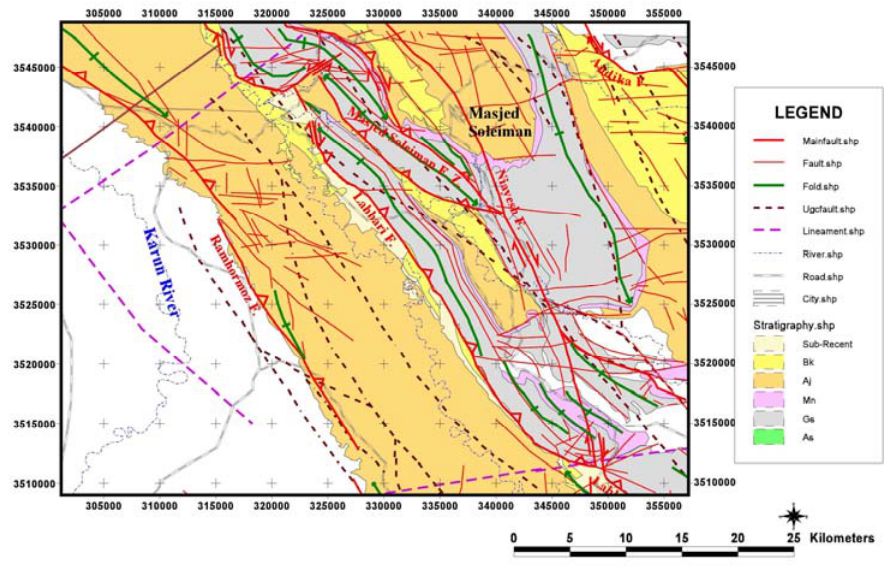
Figure 2. Geological map of the Masjed-i-Soleiman